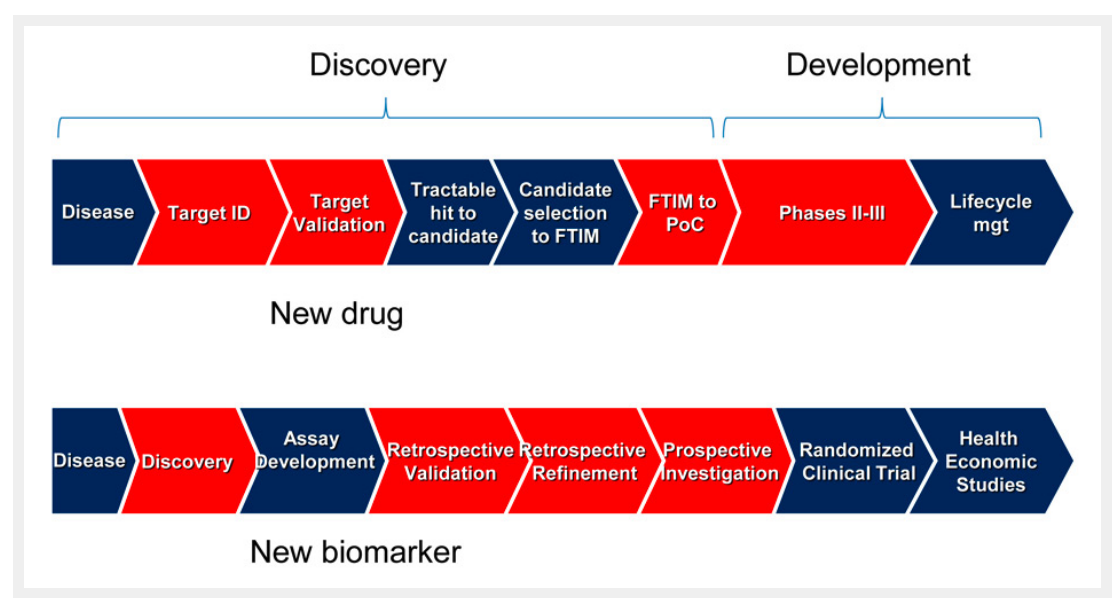
Chevron diagrams showing the various steps which lead to the discovery and development of new drugs (upper panel) and biomarkers (lower panel). Steps where genomic information and large bio-resources can be used to help decision making and accelerate the process of discovery and development are shown in red. Target ID: target identification; FTIM = first time into man; PoC = proof-of-concept. Upper part of the chevron diagram adapted from